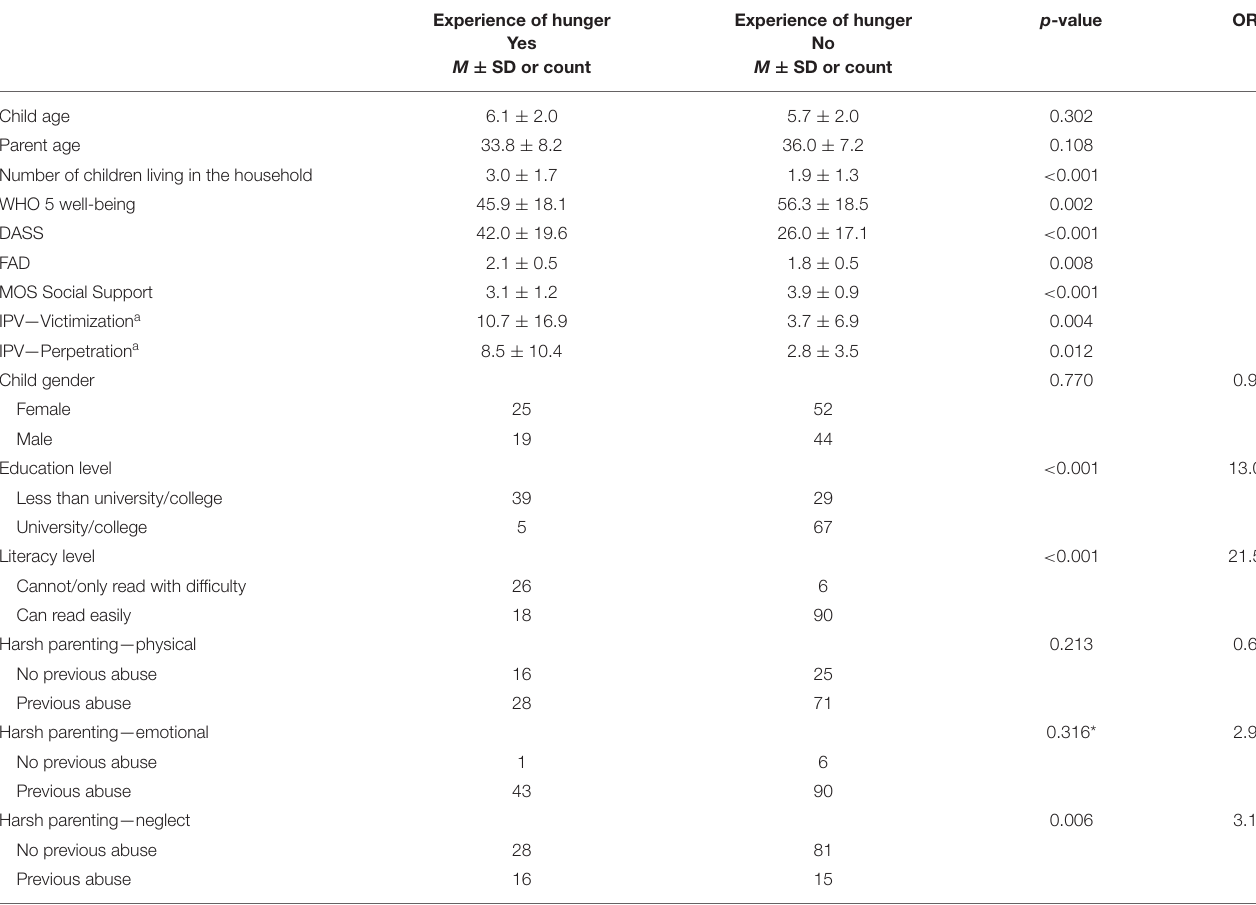
TABLE 3 | Univariate relationships between the experience of hunger (i.e., at least one form of hunger in the past month) and risk factors ( N = 140).